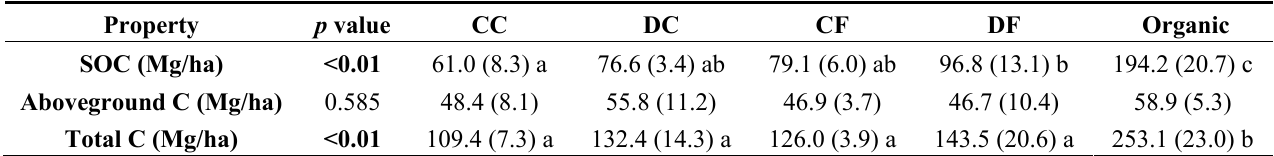
Table 6. Ecosite cluster C analysis averages (standard errors). ANOVA p values < 0.05 are highlighted in bold.